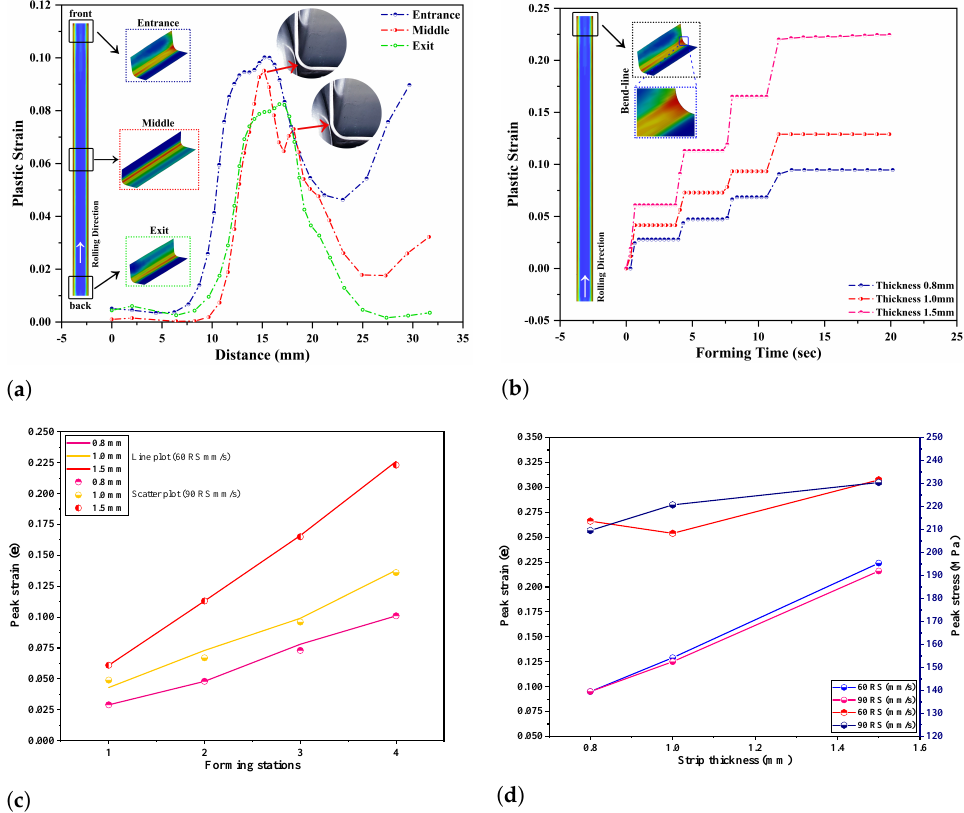
Figure 10. ( a ) Plastic strain obatined along predefined bend-line paths at roll speed of 60mms − 1 ; ( b ) plastic strain obatined from chosen element at roll speed of 60mms − 1 ; ( c ) stage-wise peak strain comparison with forming speed of 60mms − 1 and 90mms − 1 ; ( d ) comparison of stress and strain in chosen bend-line